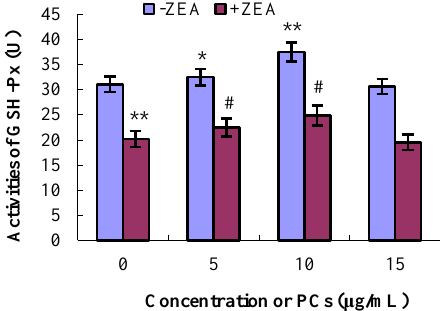
Figure 9. Effects of different concentrations of proanthocyanidins (PCs) on the activities of glutathione peroxidase (GSH-Px) exposed to zearalenone (ZEA) (65 µ mol/L). The activities of GSH-Px significantly decreased when cells were exposed to ZEA, while the activities significantly increased when cells were treated with PCs. The activities increased when the cells were co-treated with PCs/ZEA. * p < 0.05 and ** p < 0.01 vs. control group; # p < 0.05 vs. ZEA-treated group.